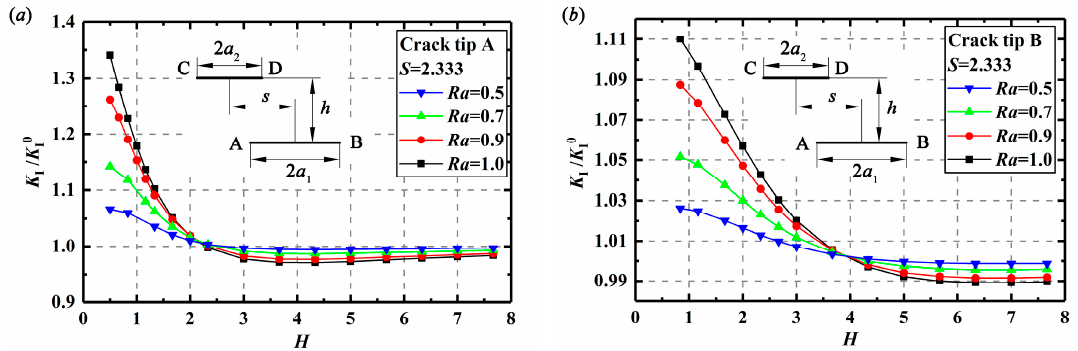
Figure 9. Relationship between K I / K I0 and H with different Ra at S = 2.333: ( a ) K I / K I0 at crack tip A and ( b ) K I / K I0 at crack tip B.